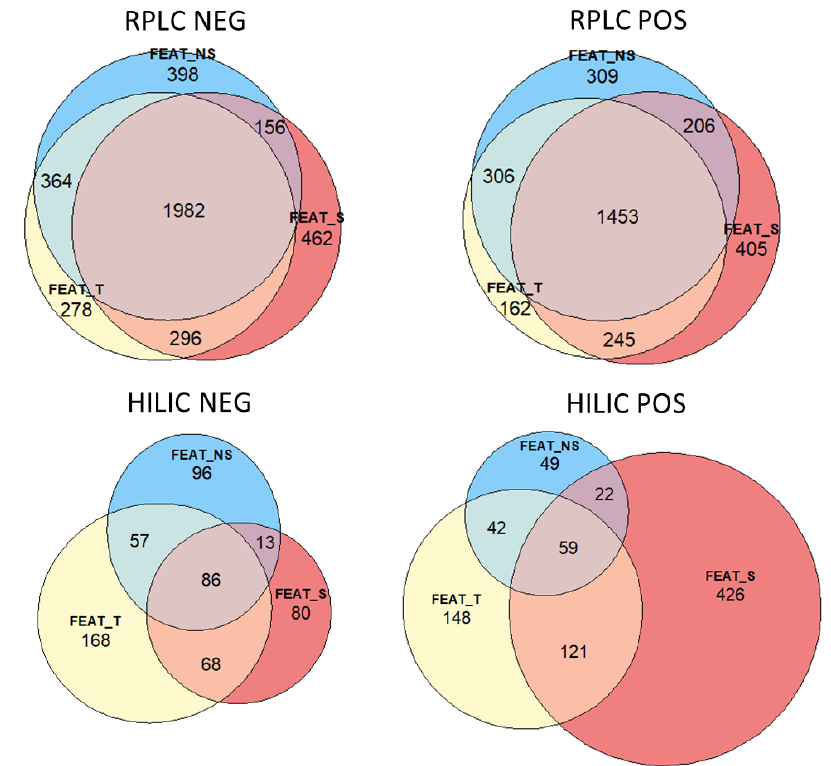
Figure 2. Eulero – Venn graphs, for each chromatographic run, showing the differences in the num- ber of features obtained by separately filtering the dataset with the QC-T (quality controls from all samples) (FEAT_T), the QC-S (quality control from smokers) (FEAT_S), or the QC-NS (quality control from non-smokers) (FEAT_NS).